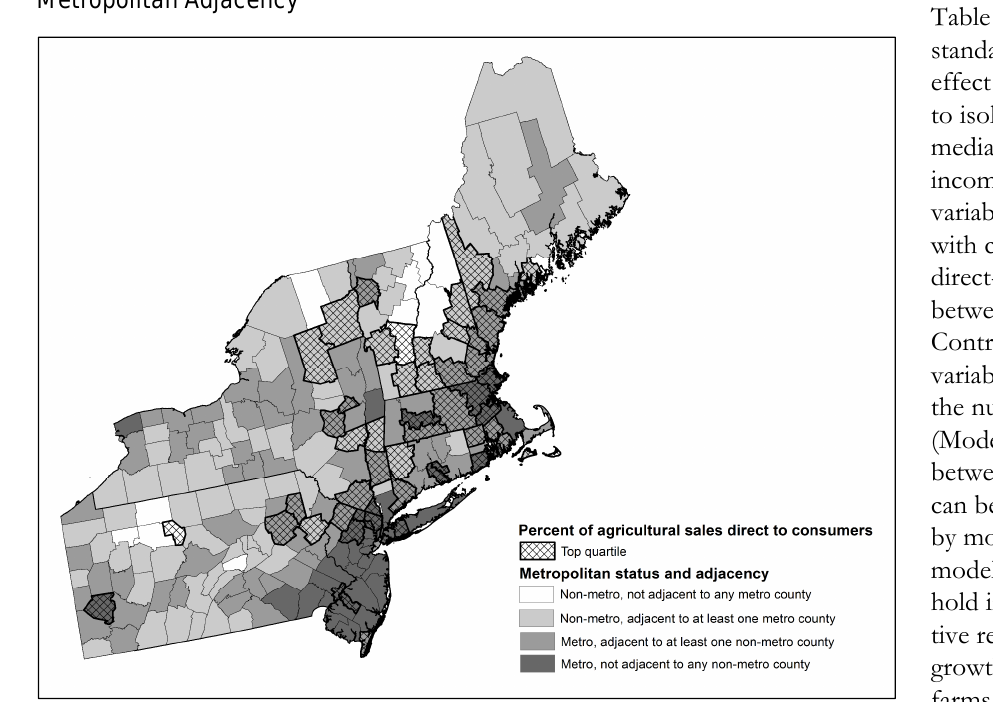
Figure 4. Top-quartile of Percent of Sales Direct to Consumer and Metropolitan